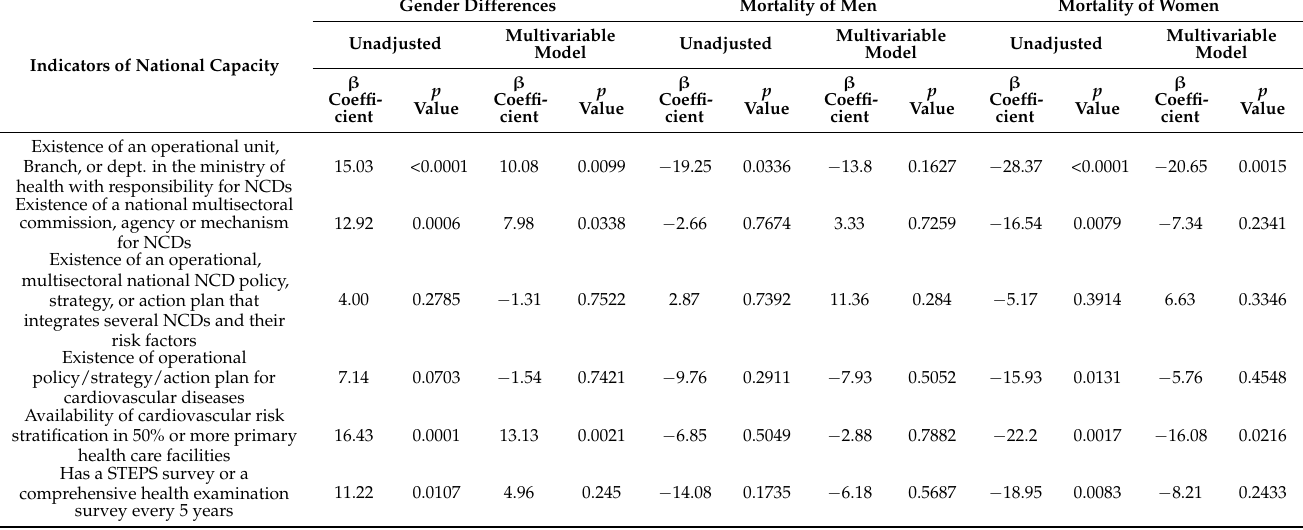
Table 3. Associations between relative gender differences in CVD mortality and national NCD prevention capacity, 2015.